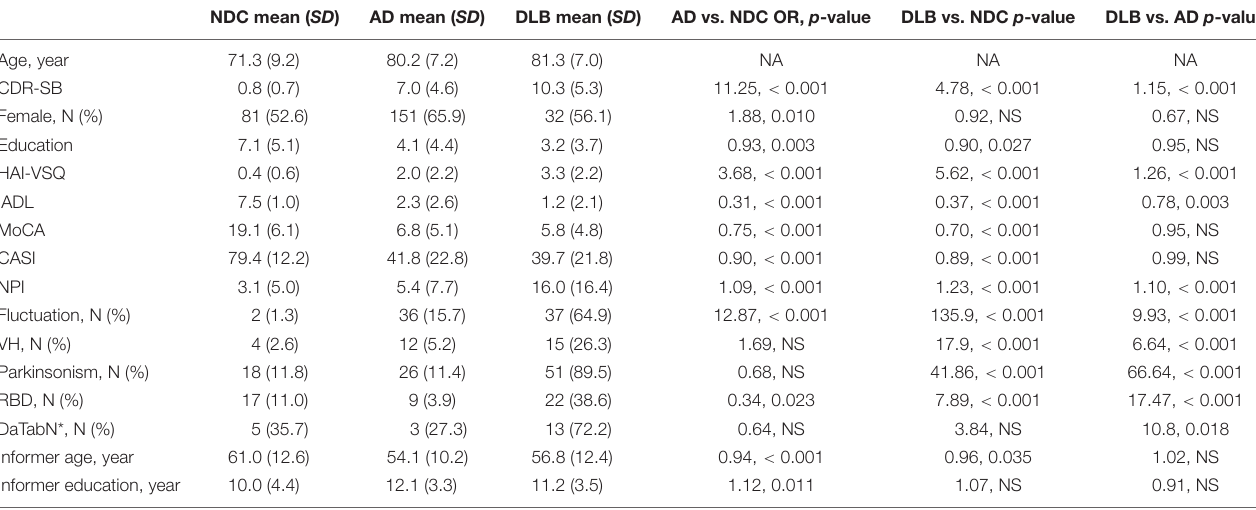
TABLE 1 | Comparison of demographic data among the NDC ( N = 154), AD ( N = 229), and DLB ( N = 57)